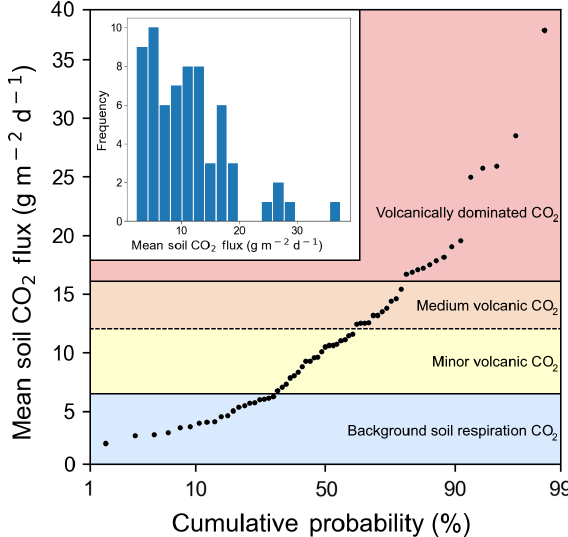
Figure 3. Soil CO 2 flux into the sub-canopy air of forests on the Turrialba–Irazú volcanic complex is pervasively and significantly influenced by a deep volcanic gas source. At least four different overlapping populations of soil CO 2 flux were identified using a cumulative probability plot, where inflection points indicate popula- tion boundaries (Sinclair 1974). 69% of sampling locations (45 to- tal) are exposed to varying degrees of volcanically derived elevated CO 2 . Populations are color-coded based on the same color scale as Fig.